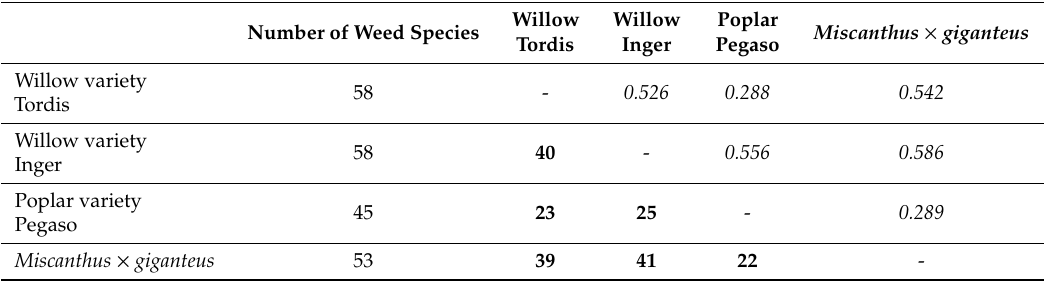
Table 2. Number of weed species in di ff erent energy crops (second column), number of shared species between two samples (bold), and similarity of weed-species composition in di ff erent energy crops evaluated by Jaccard index